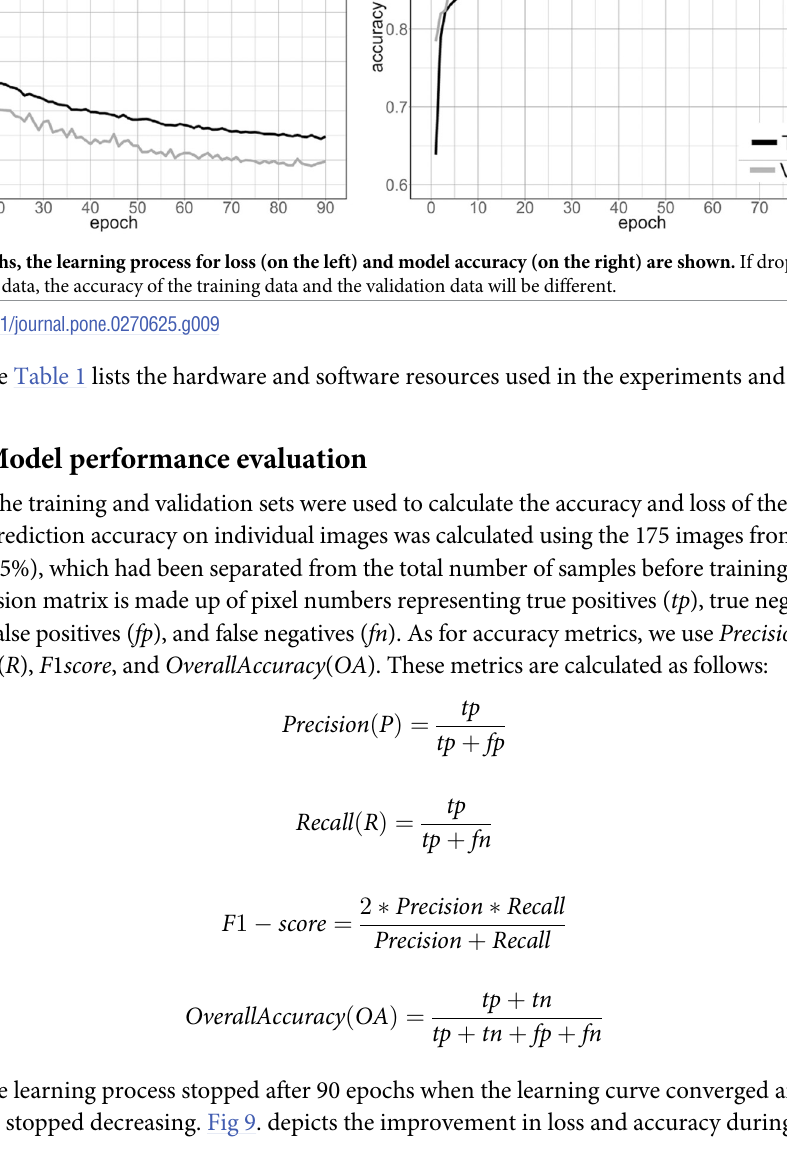
Table 1. The details of the configuration of the experimental